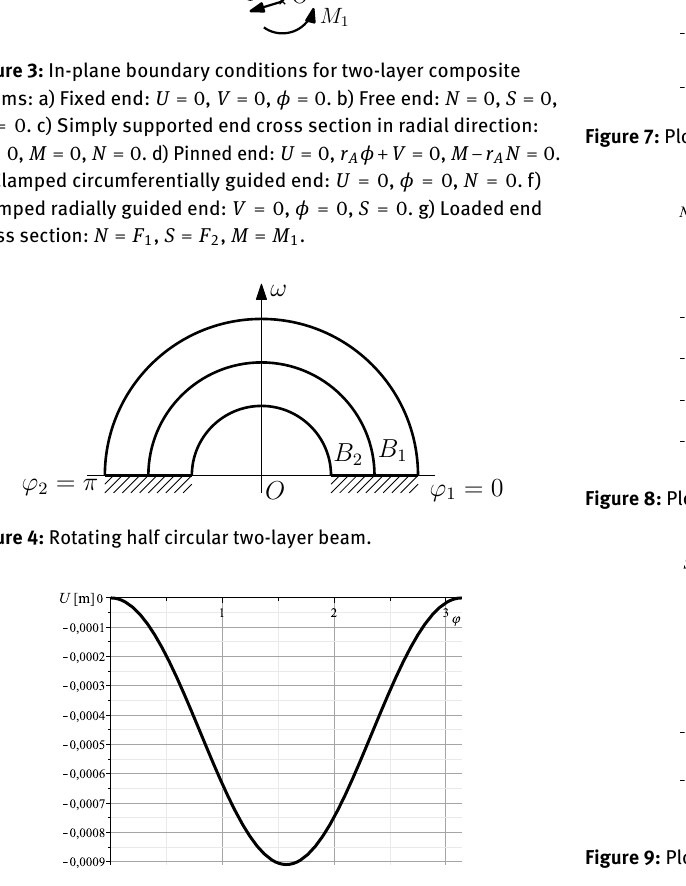
Figure 5: Plot of U ( φ ) (Example 5.1).